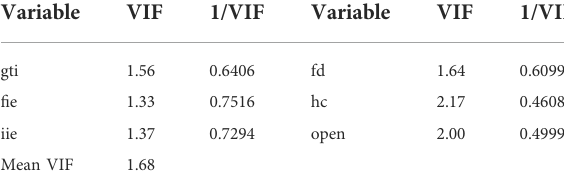
TABLE 4 VIF multicollinearity test results.